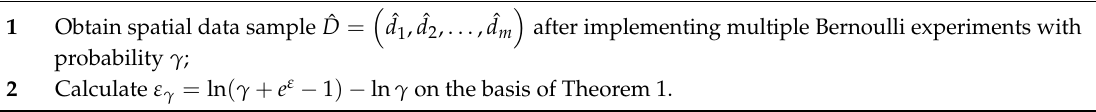
Algorithm 1 Random Sampling Algorithm with Differential Privacy ( D , ε )